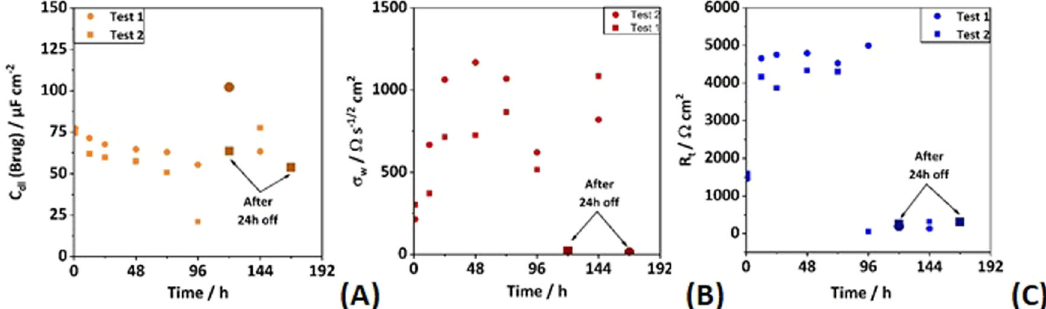
Fig. 14 Progression of the EEC parameters during the 7 days of cathodic polarization with two days of interruption (the 5th and 7th days). The double layer capacitance (Cdl) estimated with Brug ’ s law in ( A ), the Warbrug constant for the diffusion phenomenon ( σ w ) in ( B ), and the charge transfer resistance (R t) or the faradic impedance (Z f ) in ( C ), for an unpainted DH36 steel immersed for 7 days in a naturally aerated solution, in a static condition at 20 °C.